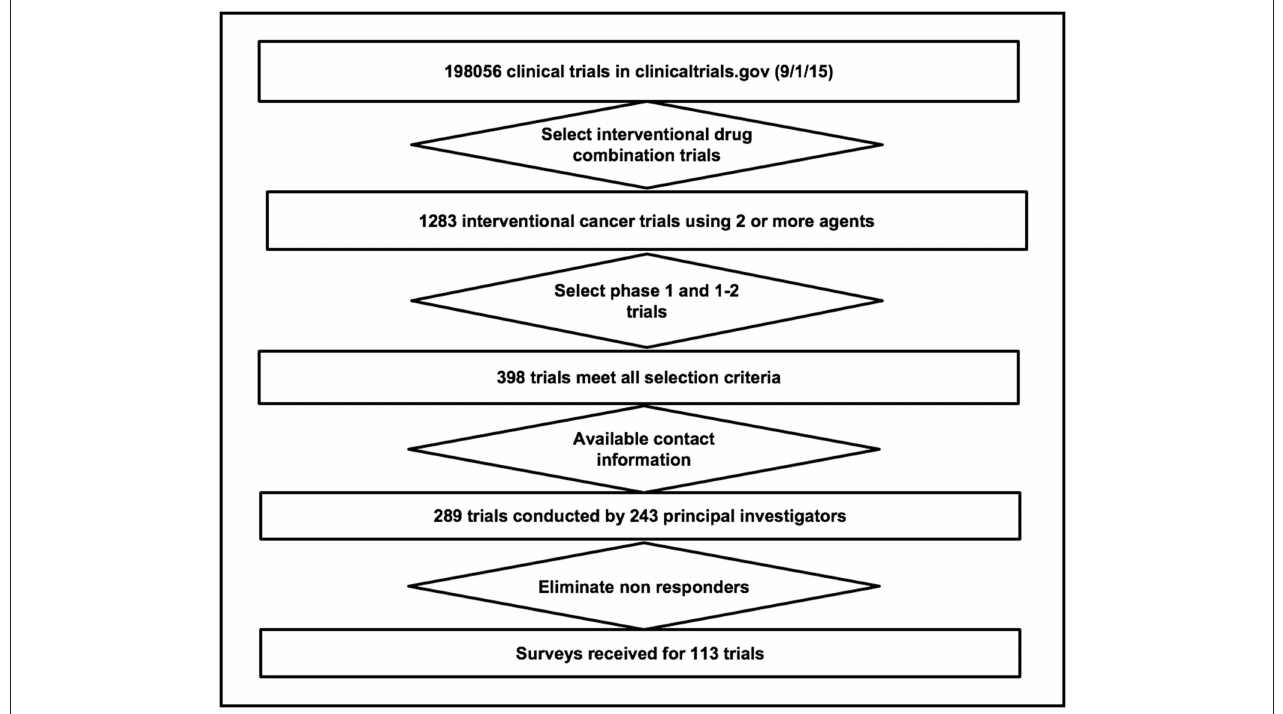
FIGURE 3 | CONSORT diagram for this